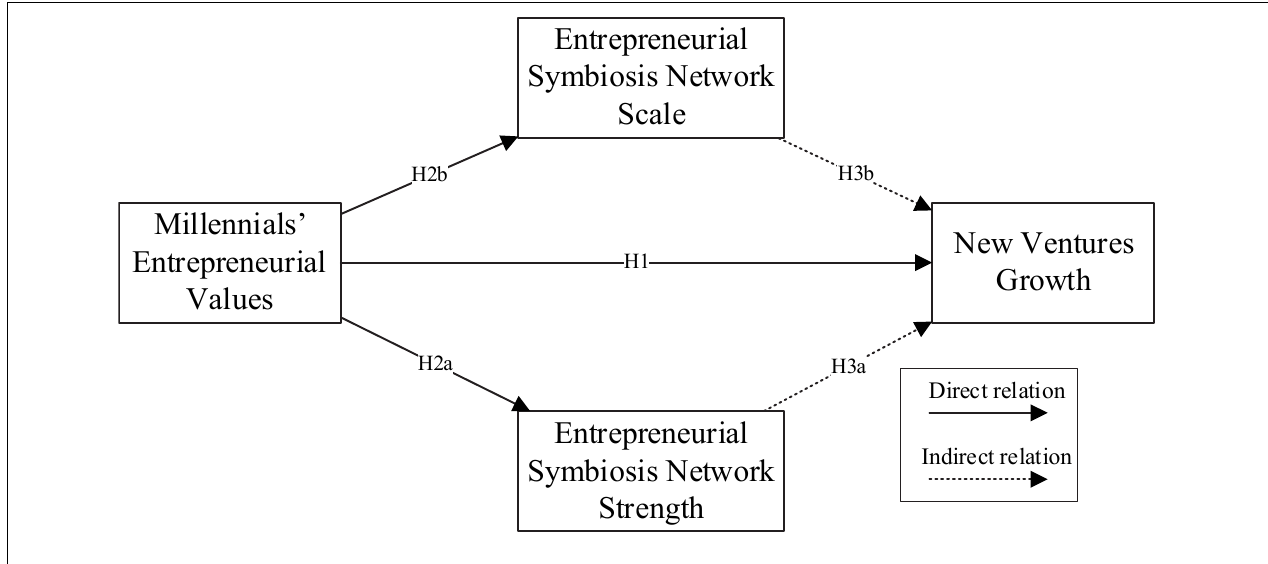
FIGURE 1 | Conceptual